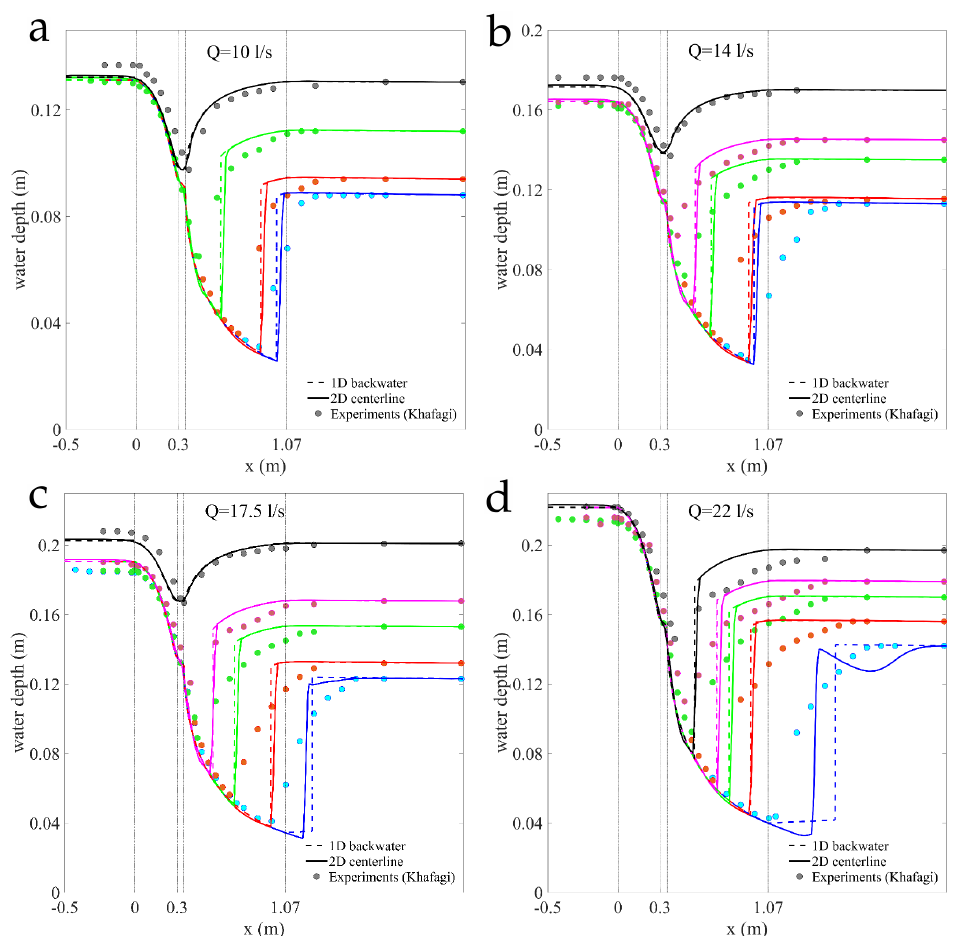
Figure 12. Predicting the transition to subcritical flow in Khafagi’s flume experiments: comparison between models and experiments for four discharges Q = 10,14,17.5 and 22 L/s (panels a – d , respectively). We use solid lines for profiles along the channel axis in 2D simulations, broken lines for the 1D theory, and circles for the experimental measurements. Line colors correspond to different imposed tailwater